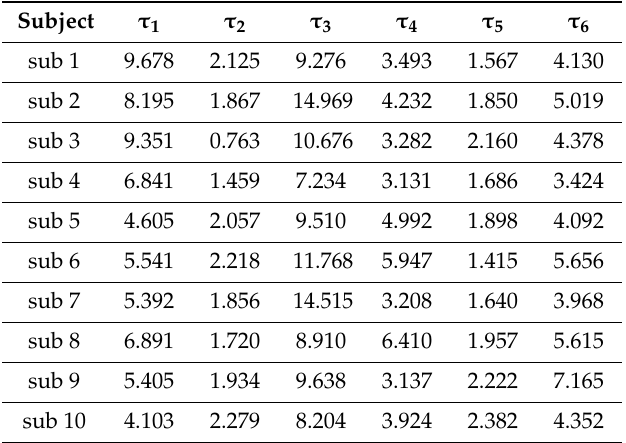
Table 2. Comparison of τ